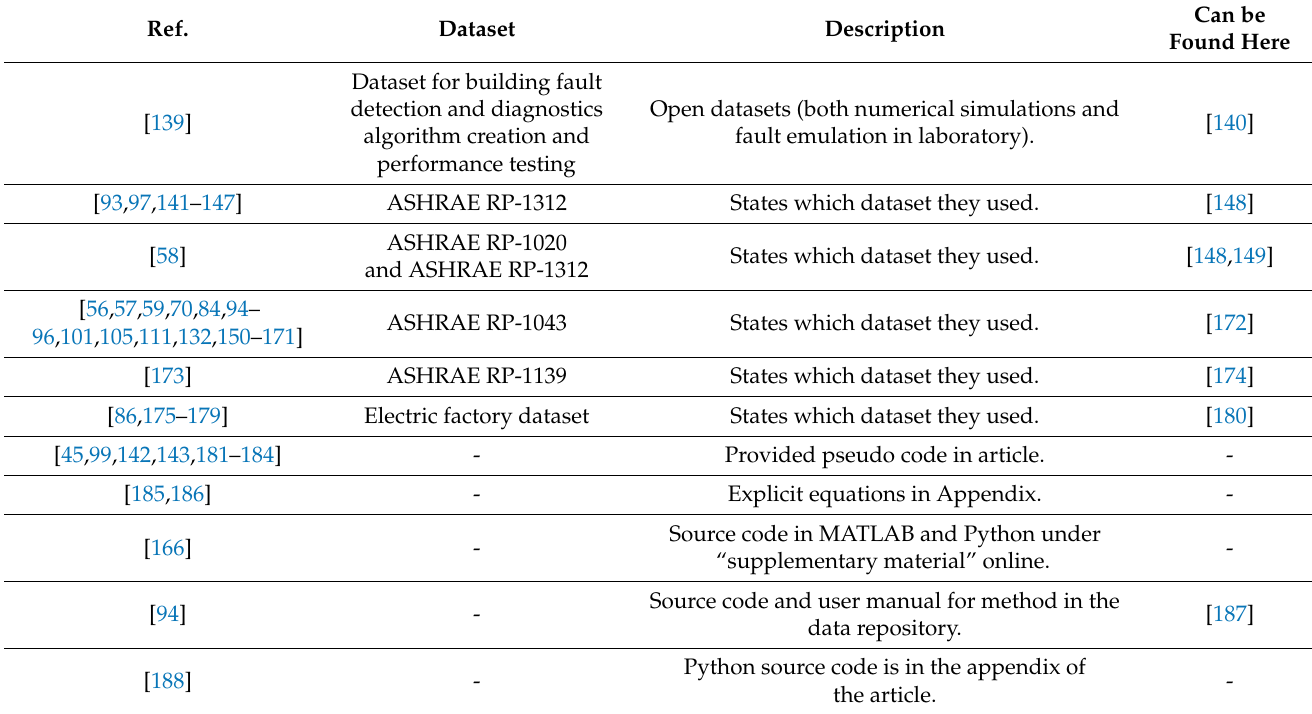
Table 8. Datasets and code used in the explored literature.